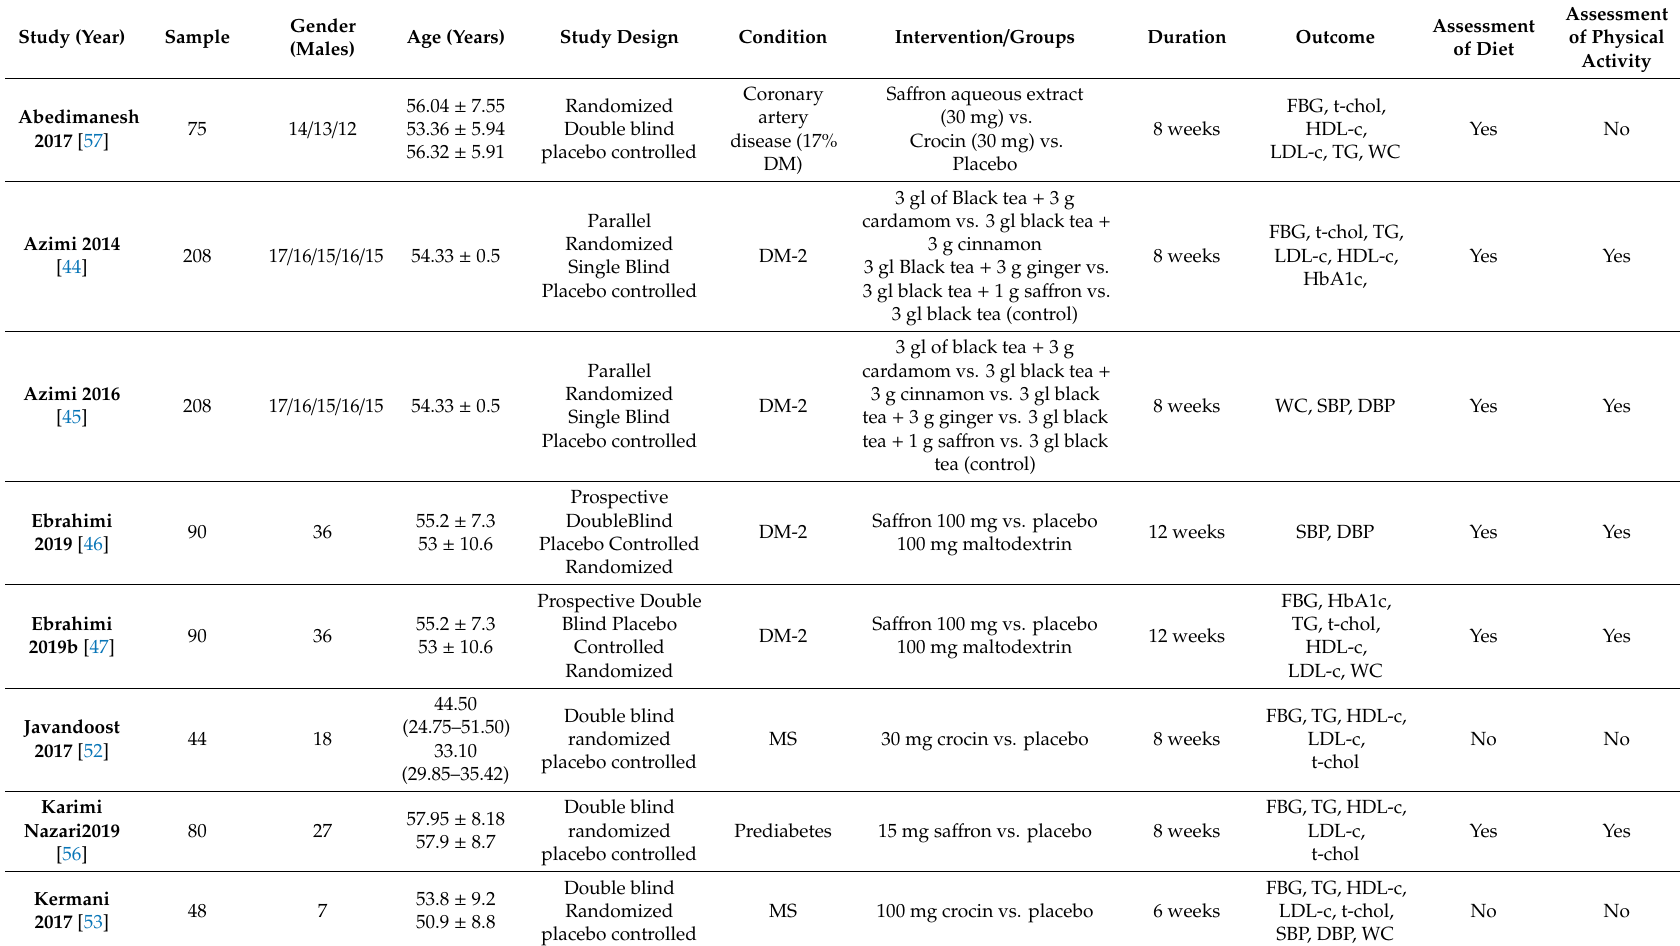
Table 1. Summary of study